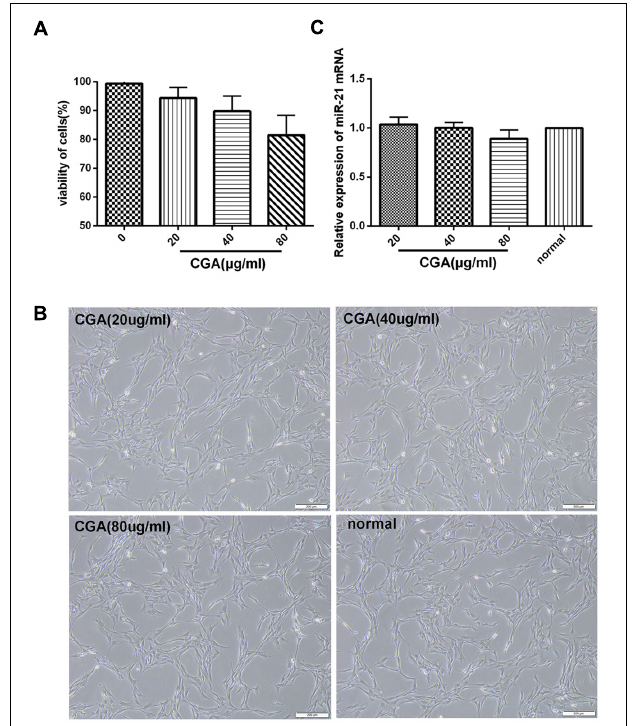
FIGURE 1 | Cytotoxicity of CGA on LX2 cells was determined by CCK8 assay. (A) LX2 cells plated in 96-well plates were treated with CGA for 24 h, and cell viability was determined. (B) Cell morphologies of LX2 after CGA treatment for 24 h. (C) The mRNA level of miR-21 was measured by quantitative real-time